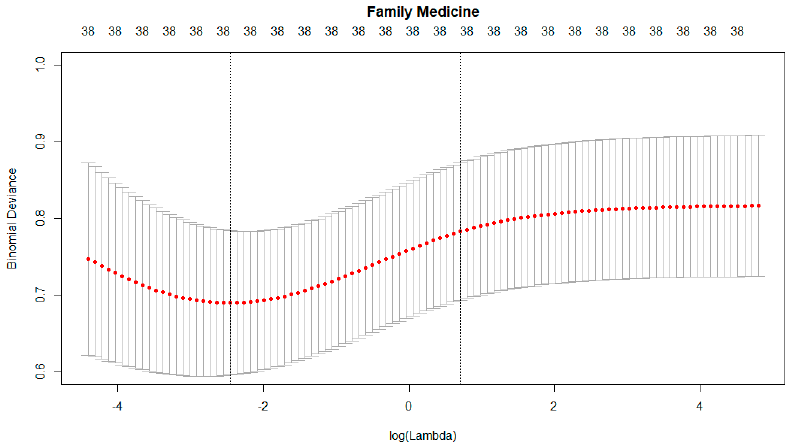
Figure 4. The hyper-parameter (cid:2019) of the Department of Family Medicine.